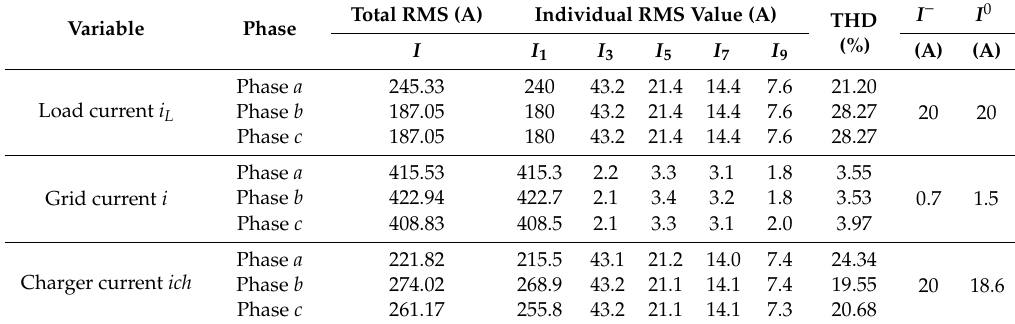
Figure 8. Simulation results. Case D. Charging the EV battery and injecting fundamental reactive power: 𝑃 ∗ = 120 kW and 𝑄 1 ∗ = 120 kVAr. CS demand with harmonic and unbalanced components. 𝐼 𝐿𝑒 = 208.3 A. Table 6. Load, grid, and charge of the current harmonic and imbalanced content for case D.